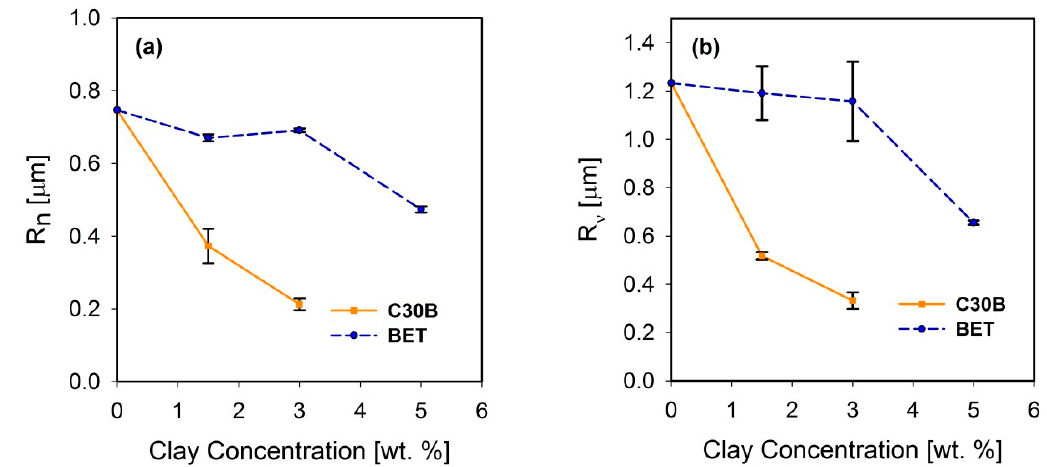
Figure 3. ( a ) Number average and ( b ) volume average droplet radii of the PLA/PBS/J blends filled with C30B and BET. The dashed and solid line plots represent the blends with BET and C30B, respectively. The morphology of the 5 wt % C30B-filled blend was not quite distinct for calculating droplet sizes. BET is Betsopa™, C30B is Cloisite ® 30B, and J is Joncryl.